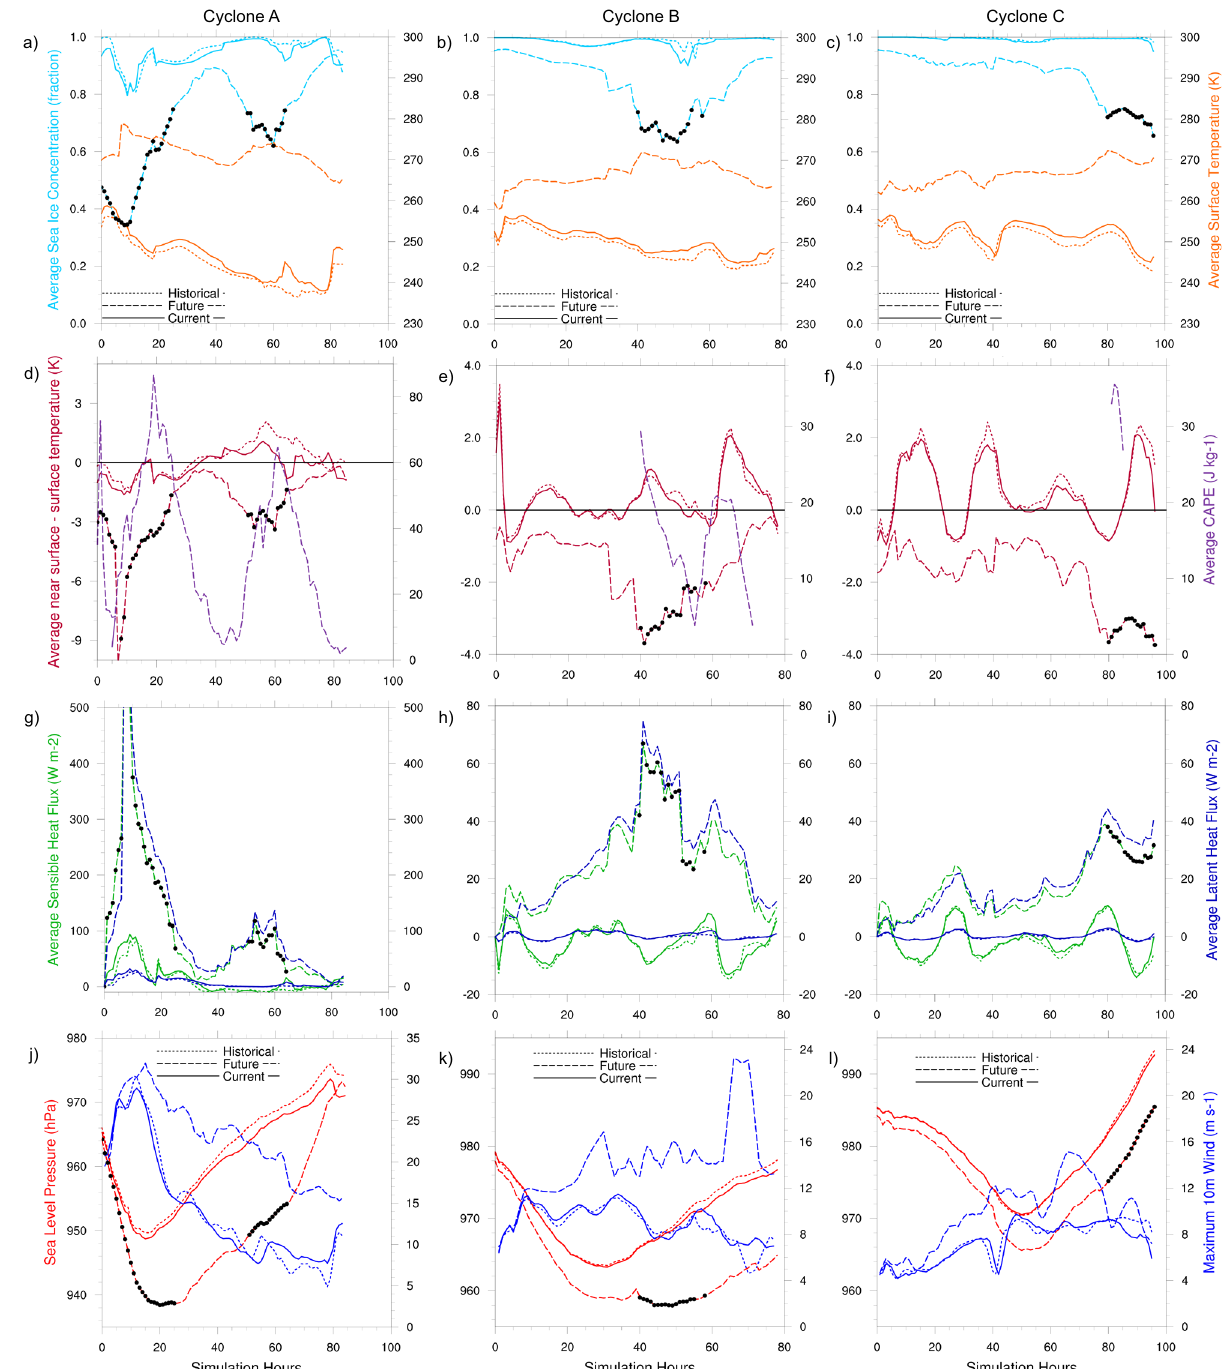
Fig. 3 | The evolution of surface and thermodynamic conditions and cyclone intensity over the cyclone lifecycles in contrasting climates. The hourly sea ice concentration (fraction) and surface temperature (K) ( a – c ), the difference in near- surface air temperature and surface temperature (K) and Convective Available PotentialEnergy(Jkg − 1 )( d – f ),sensibleandlatentheat fl uxes(Wm − 2 )( g – i )averaged